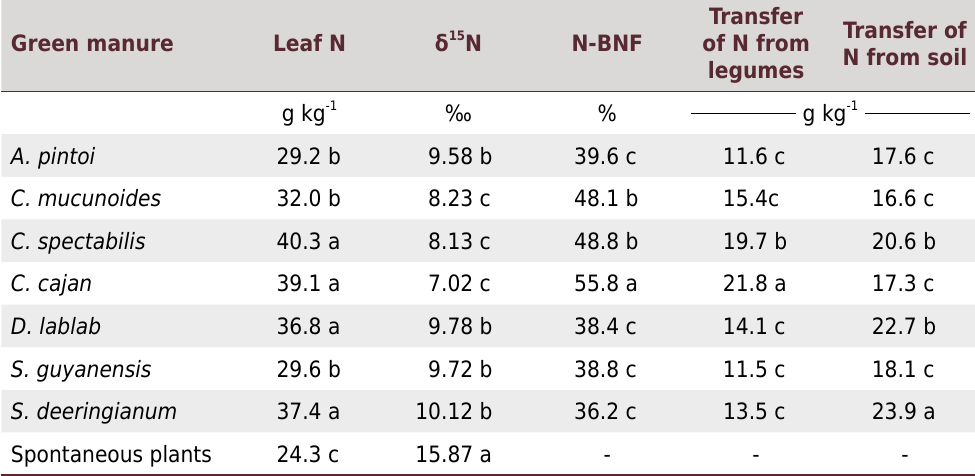
Table 4. Leaf nitrogen levels of the coffee plants, natural abundance of 15 N (δ 15 N) in coffee leaves, the contribution of nitrogen from N-BNF to the nitrogen levels in coffee leaves, and the transfer of nitrogen from the legumes and from the soil to the leaves of the coffee plants in the Zona da Mata region, state of Minas Gerais, Brazil